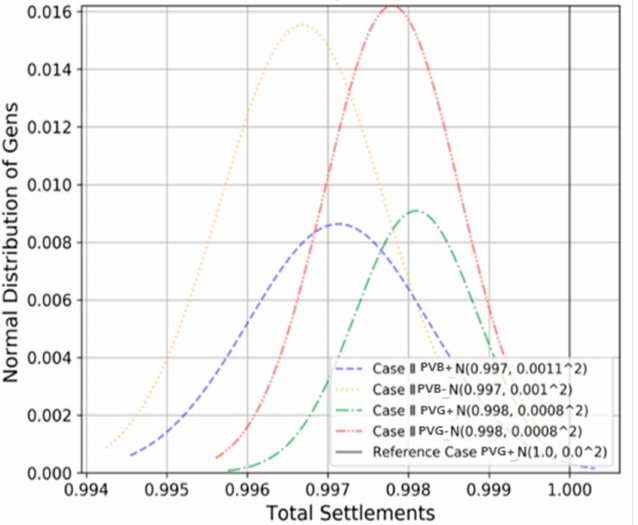
Figure 7. Distribution of PVs revenue in each group under Case